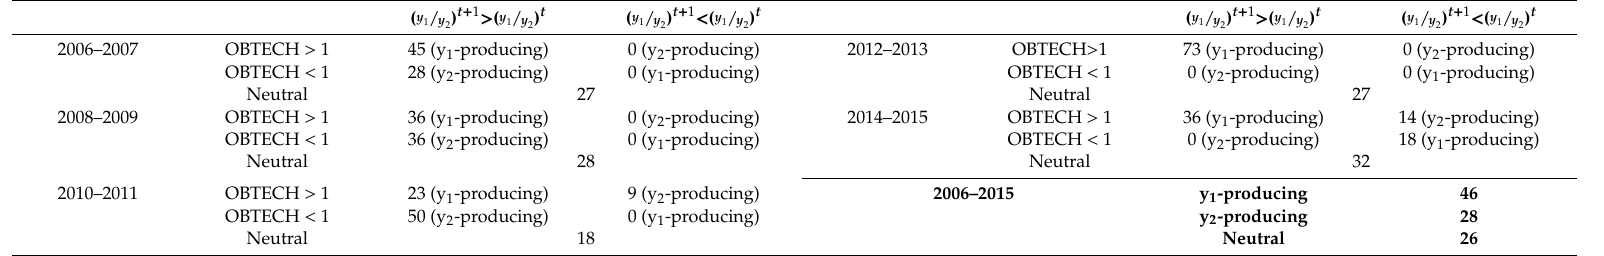
Table 5. Output-biased technical change (%) a